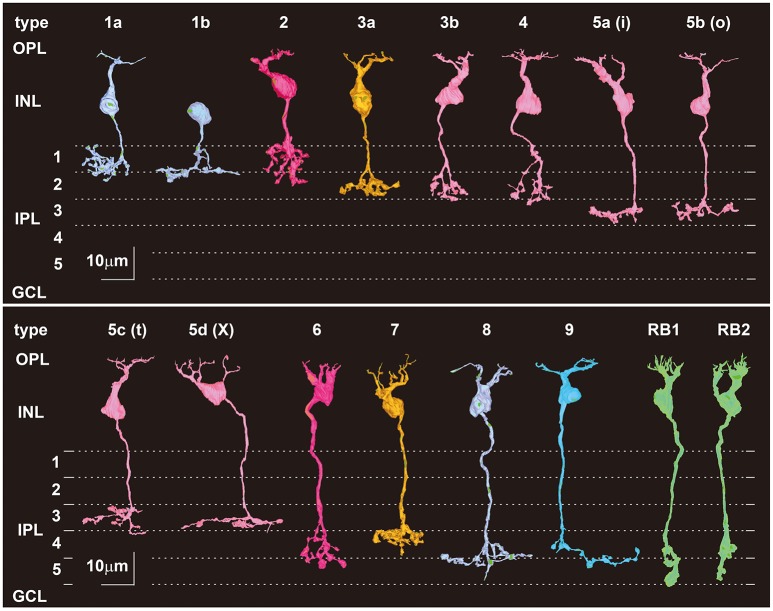
Morphology and stratification of all 15 types of mouse bipolar cells. The first six types (1a, 1b, 2, 3a, 3b, and 4b) are center-OFF response-type cells, which have axon terminals in the outer sublamina (strata 1 and 2) of the inner plexiform layer (IPL). The last nine types [5a, 5b, 5c, 5d, 6, 7, 8, 9, and rod bipolar (RB)] are center-ON response-type cells, which have axon terminals in the inner sublamina (strata 3, 4, and 5) of the IPL. Type 1b is morphologically unipolar but regarded as a bipolar cell class based on cell lineage. RB cells are divided into two groups: RB1, the cells of which have axon terminals extending upon or into the ganglion cell layer (GCL), and RB2, the cells of which have axon terminals beyond the GCL. The other 13 cell types (1a and 2–9) are cone bipolar cells. Each stratum of the IPL (1–5) is 8 μm thick.